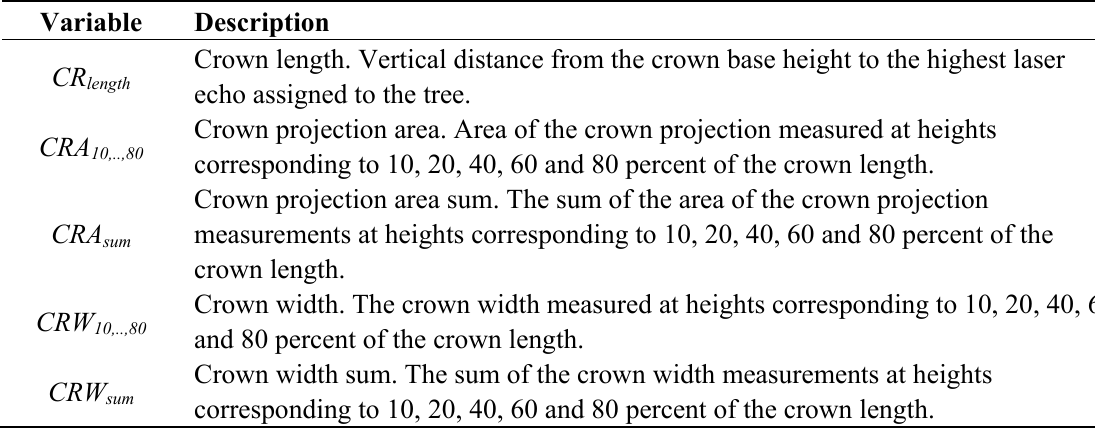
Table 2. Description of the variables derived from crown measurements in the TLS